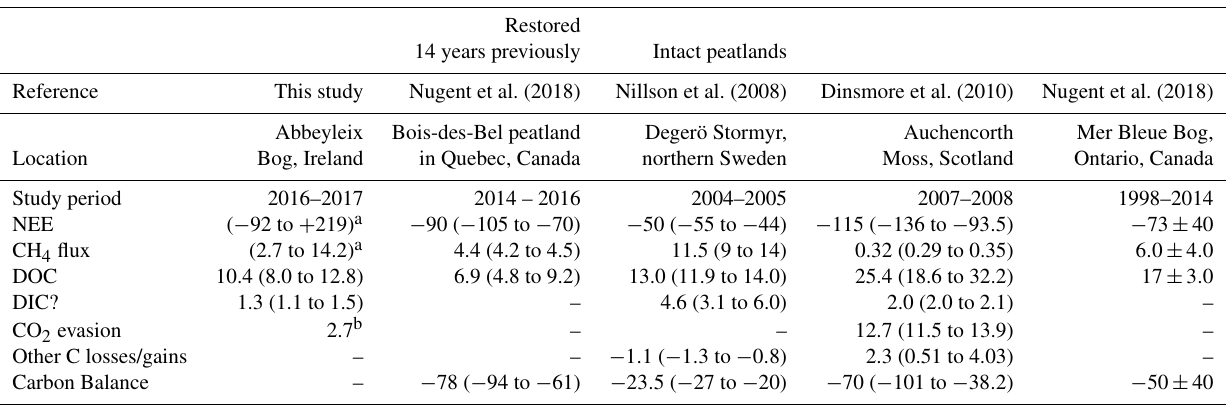
Table 2. This table shows the average annual C balance from various studies which have measured multiple aspects of the C balance. All units are in gCm − 1 yr − 1 , with a negative sign convention indicating C uptake to the bog. Where 2 or 3 years of data were available the range is given (min to max); where more years of data were available ± SD is